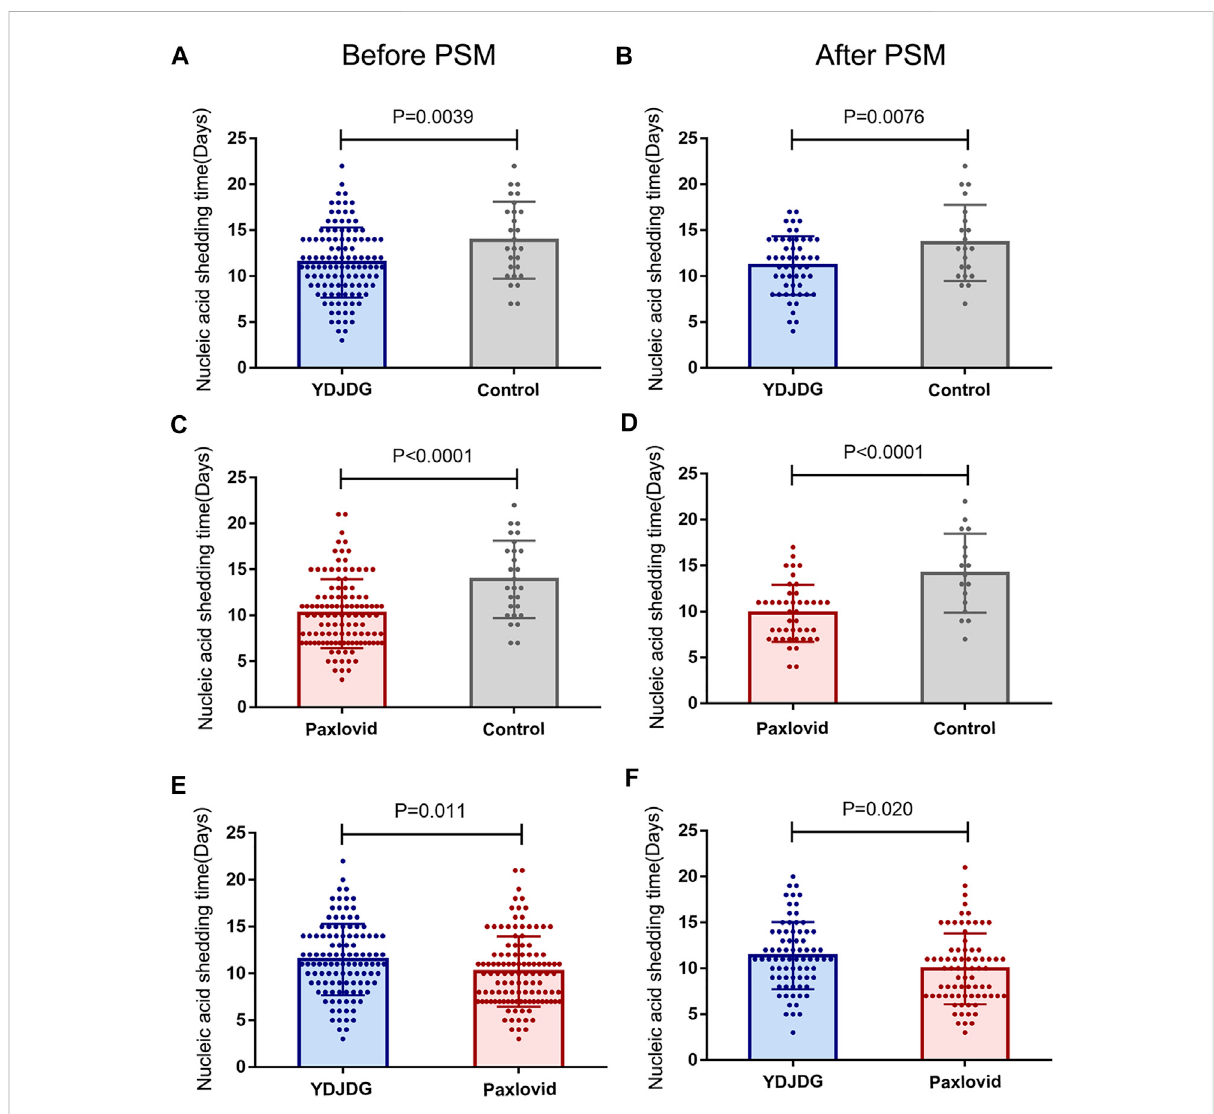
FIGURE 3 The nucleic acid shedding time before and after PSM. Comparison of the YDJDG and the control group before (A) and after (B) PSM. Comparison of the Paxlovid and the control group before (C) and after (D) PSM. Comparison of the YDJDG and the Paxlovid group before (E) and after (F) PSM. YDJDG, Yindan Jiedu granules; PSM, propensity score